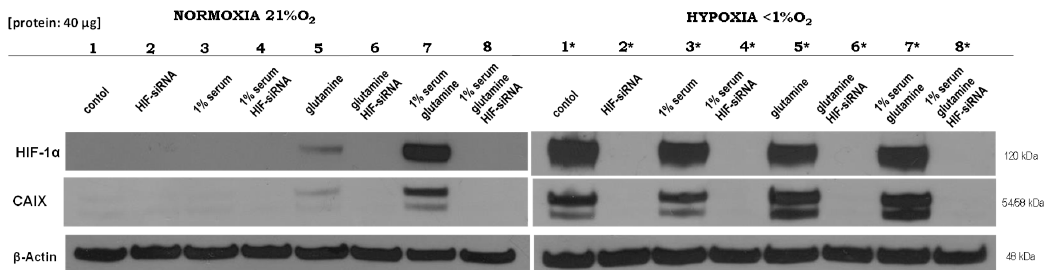
Figure 1. Altered HIF1 α -dependent e ff ects of normoxia and hypoxia under di ff erent culture conditions. Western blot analysis was performed 24 h after the application of di ff erent treatments for HIF1 α and carbonic anhydrase (CAIX), while β -actin served as a control. (Lane 1) Medium control; (lane 2) siRNA against HIF1 α ; (lane 3) 1% fetal bovine serum; (lane 4) 1% fetal bovine serum and siRNA against HIF1 α ; (lane 5) 5 mM glutamine; (lane 6) 5 mM glutamine and siRNA against HIF1 α ; (lane 7) 1% fetal bovine serum and 5 mM glutamine; and, (lane 8) 1% fetal bovine serum, 5 mM glutamine and siRNA against HIF1 α under normoxic or hypoxic (*) conditions in MDA-MB-231 cells. The experiments were performed in RPMI 1640 in the presence of 11.1 mM glucose, but without glutamine. Deep sequencing analysis was performed for each of the corresponding RNA samples (lanes 7, 8, 7*, and 8*) from four independent experiments (Please see Supplemental Figure S3 and the results from the densitometric evaluation of the Western blots of four independent experiments).